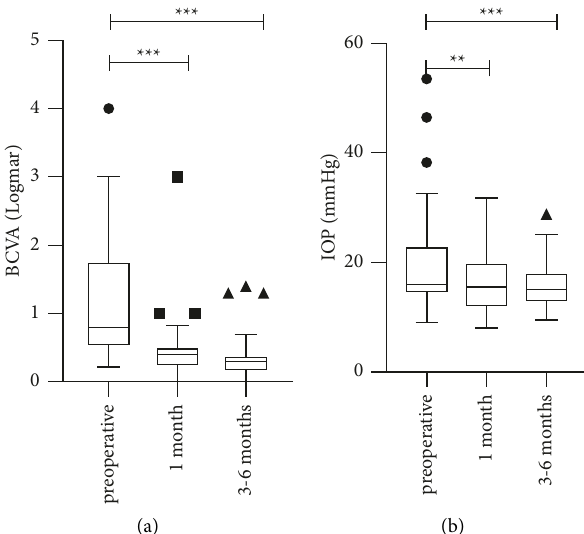
Figure 2: BCVA: best-corrected visual acuity; IOP: intraocular pressure. (a) Changes of BCVA in all subjects. (b) Changes of IOP in all subjects. ∗ P < 0 . 05; ∗∗ P < 0 . 01; ∗∗∗ P < 0 .